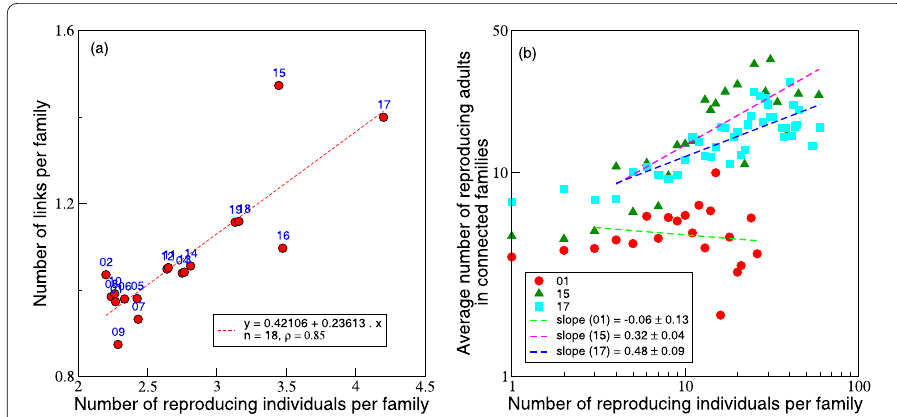
Figure 9 Aspects of the network as functions of the number of reproducing individuals in the family. ( a ) The variation of number of links per family in the network of families with number of reproducing individuals per family. The regions to which each of the points correspond are denoted by the labels. The dashed line is a linear regression fit. ( b ) For a family with a given number ( x ) of reproducing individuals in a given region, we count the total number of reproducing individuals in all the families (belonging to the same region) connected to it, and then divide by the number of connections (gives y ). For each x we calculate the mean y . These values are shown as scatter plots for three different regions, namely, Uusimaa (circles), Pohjanmaa (triangles) and Pohjois-Pohjanmaa (squares). The dashed lines are linear regression fits for log( y ) versus log( x ), with slopes provided in the legend. Unlike in the case of Uusimaa, for Pohjanmaa and Pohjois-Pohjanmaa the slopes are significantly greater than